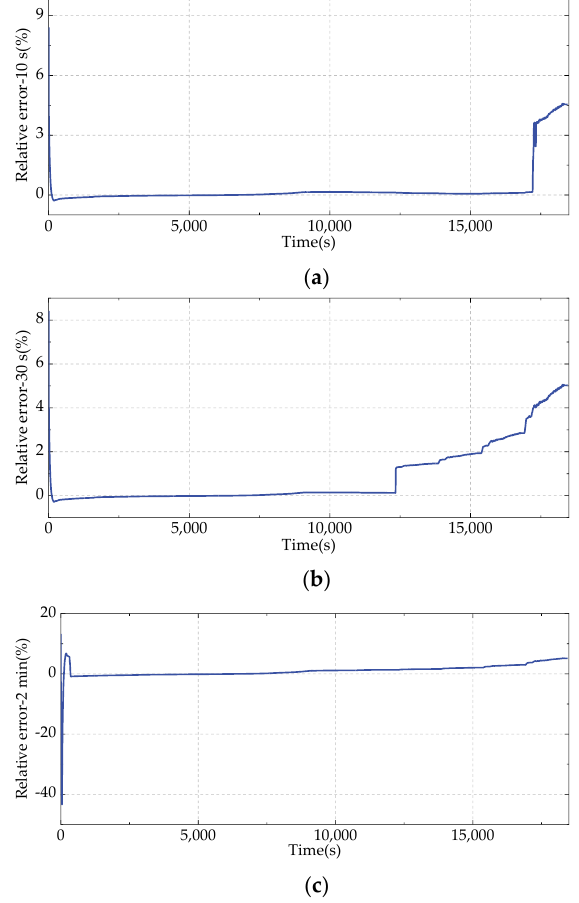
Figure 16. Results of peak discharge power relative error: ( a ) 10 s; ( b ) 30 s; ( c ) 2 min. Table 1. Estimation errors of sustained peak charging power for different time scales.